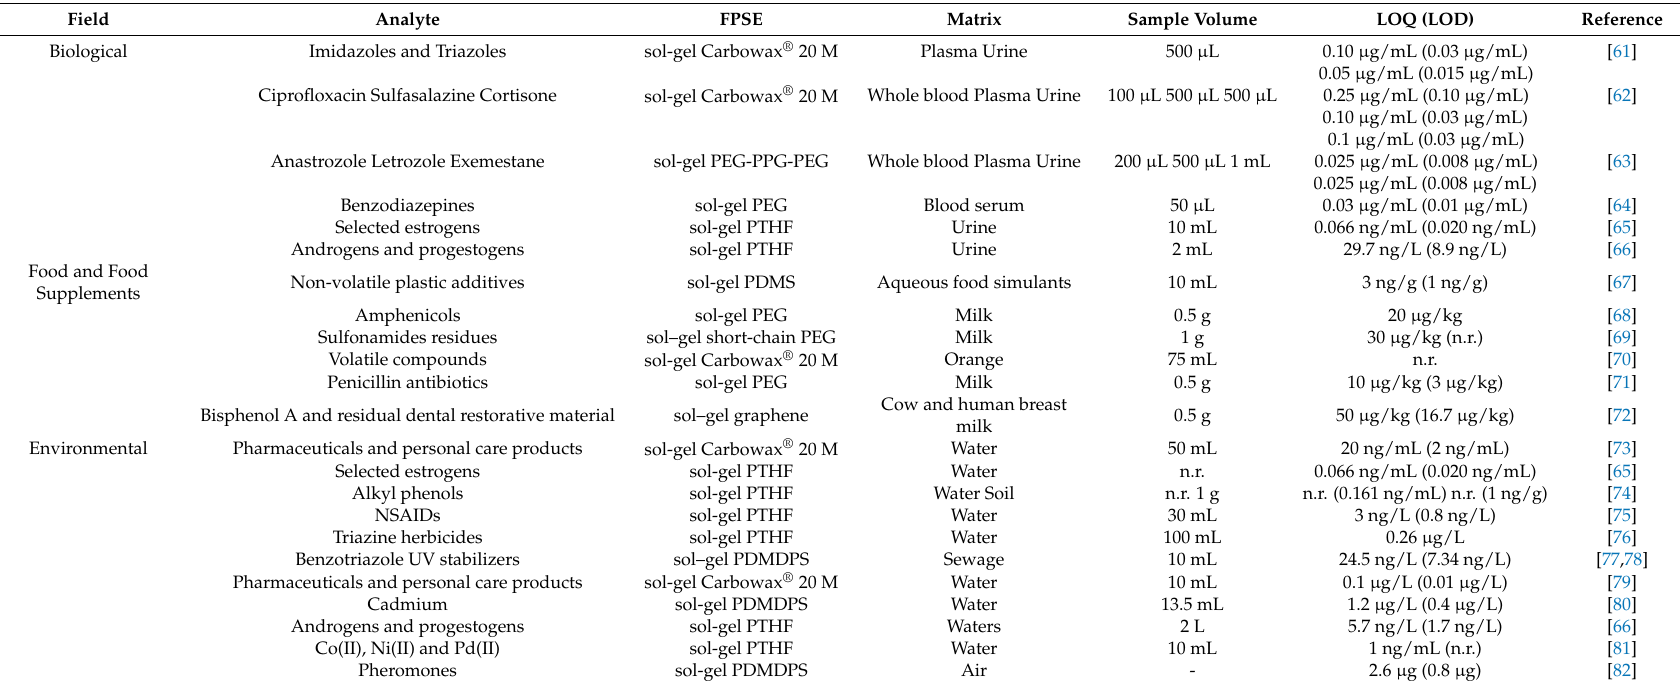
Table 2. Some recent FPSE applications in different fields, and the performances obtained when applying this